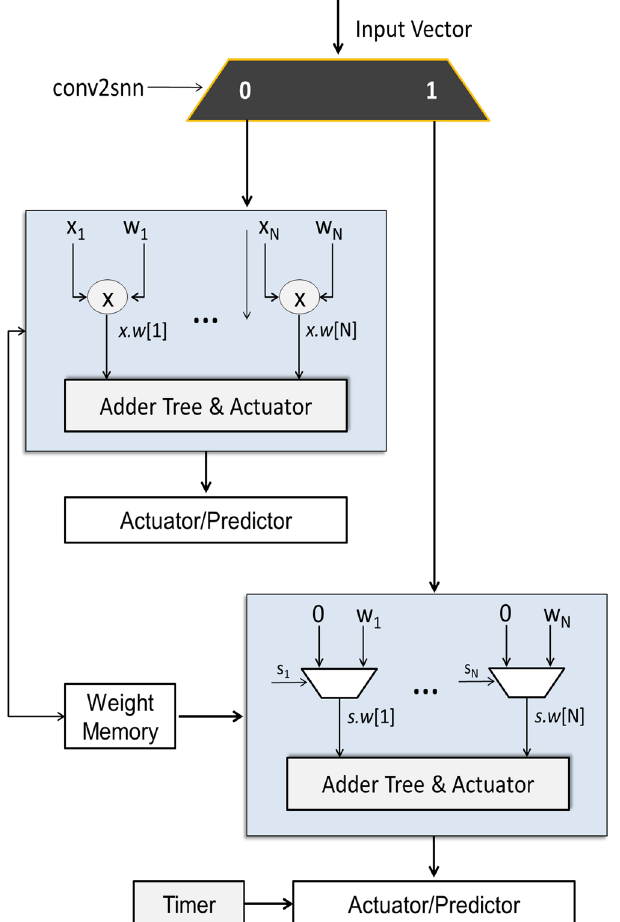
Figure 3. Reconfigurable Inference